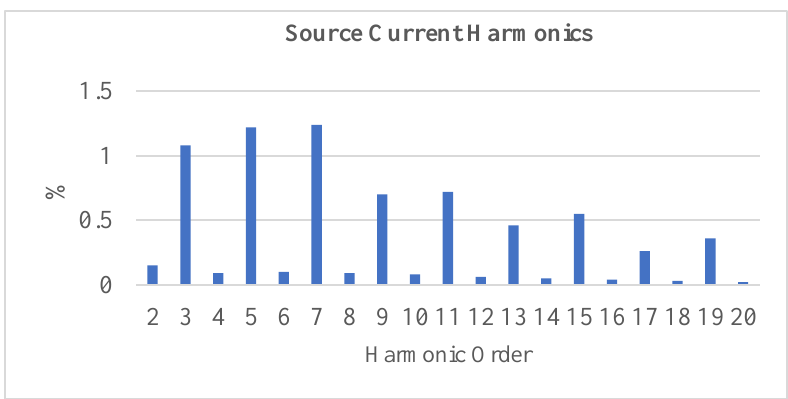
Figure 11. Source Current Harmonics with PQ-Theory Control Algorithm.